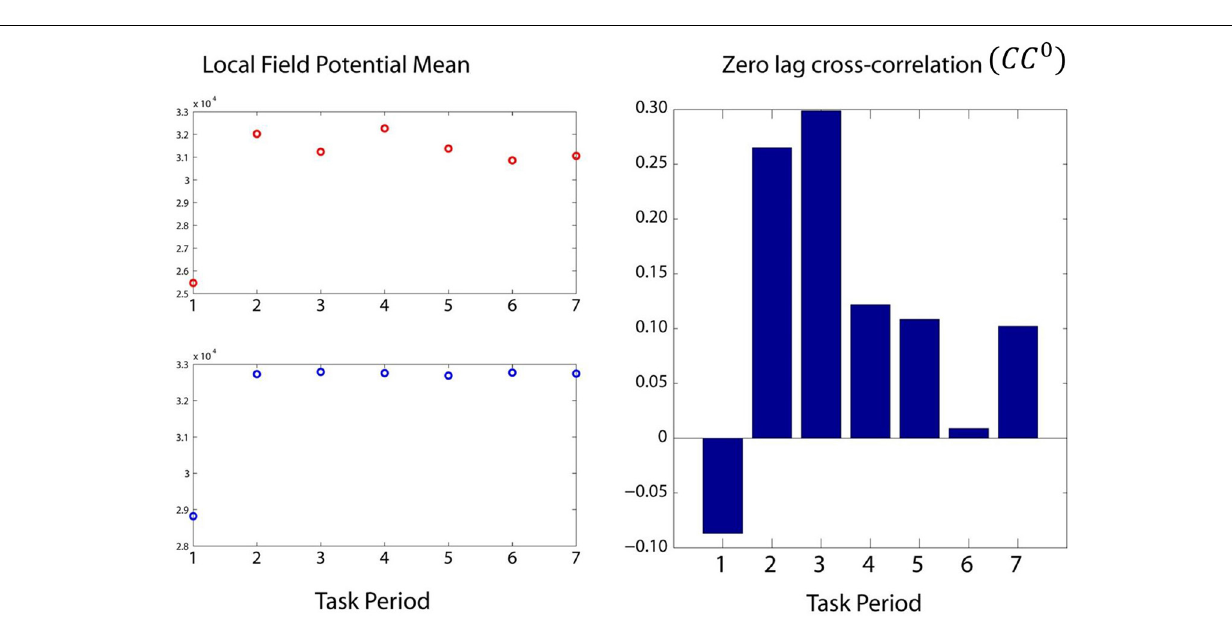
FIGURE 5 | Modulation of two LFPs (left panel) and their zCC 0 (right panel) during the seven task periods. Although the LFP magnitude increased after the first period, it did not show